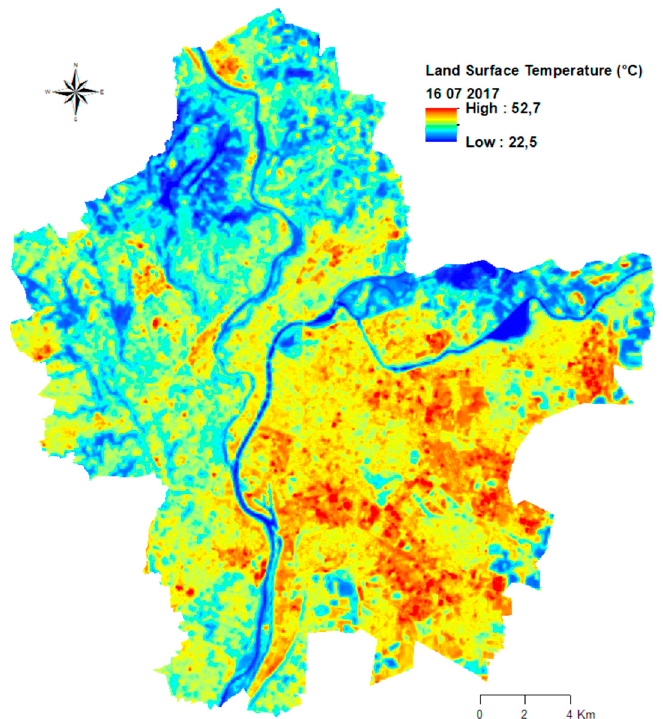
Figure 5. Land-surface temperature (LST) of Greater Lyon on 16 July 2017.